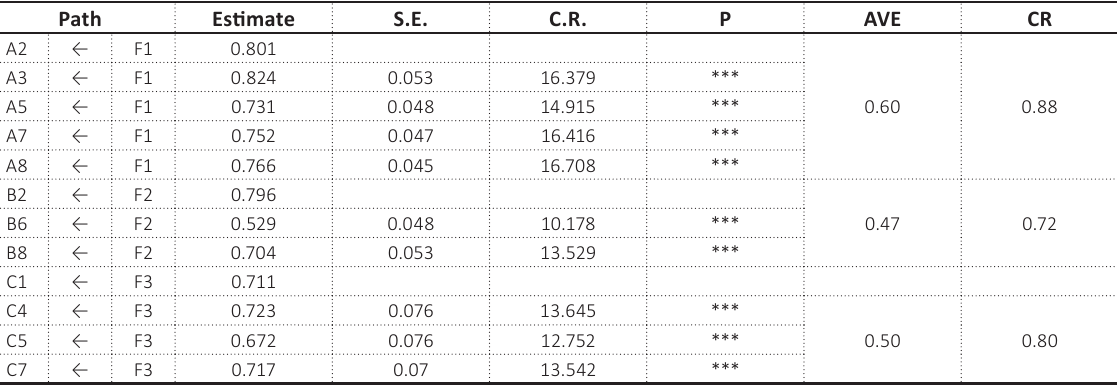
Table 5. Validation of convergence: AVE and CR Path